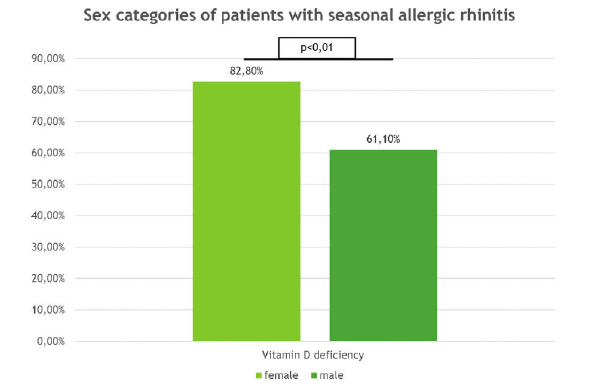
Figure 4 - Prevalence of vitamin D deficiency among men and women with seasonal allergic rhinitis